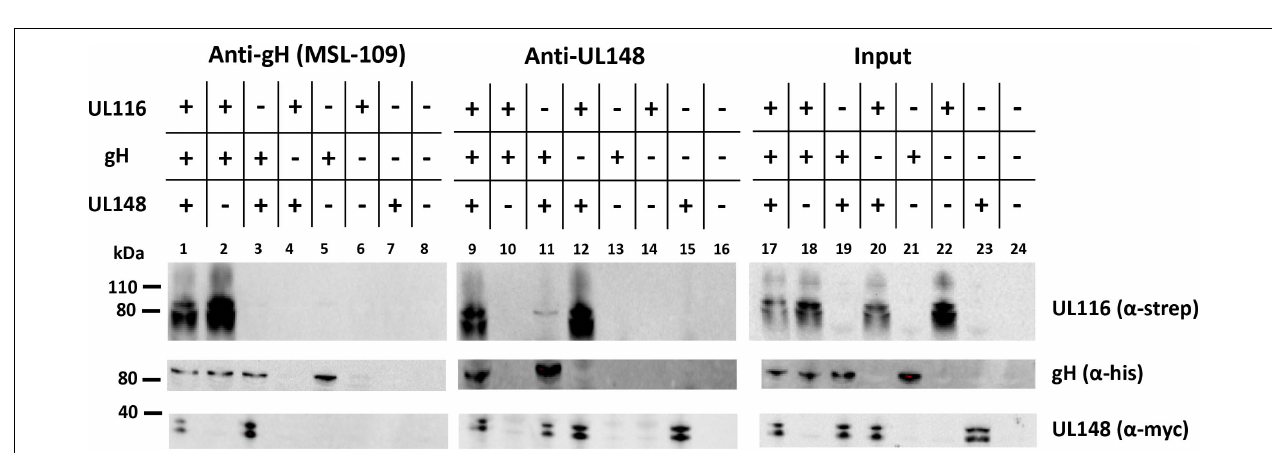
FIGURE 6 | Co-immunoprecipitations of WCL from HFF cells infected with TRG, TRG-UL148myc and TRG-UL 148- null. HFF-1 cells were infected for 6-days at MOI 1 with TRG, TRG-UL148myc, and TRG- UL148- null. Infected and non-infected cell lysates were immunoprecipitated with beads only (lanes 1, 5, and 9), Anti-gH (MSL-109; lanes 2, 6, and 10), anti-UL116 (H4; lanes 3, 7, and 11) and anti-myc to reveal UL148 (lanes 4, 8, and 12) as indicated on the top of the lanes. Protein separation was achieved on 4–12% NuSieve gels (Invitrogen) and probed in western blot by anti-His, anti-myc and mAb F11 for gH, UL148 and UL116, respectively (indicated on the right). GAPDH was used as marker to normalize lysate amount and to exclude contamination in immunoprecipitations. Whole cell lysates (imput, lanes 13–16) were also probed for detection of the individual HCMV proteins.